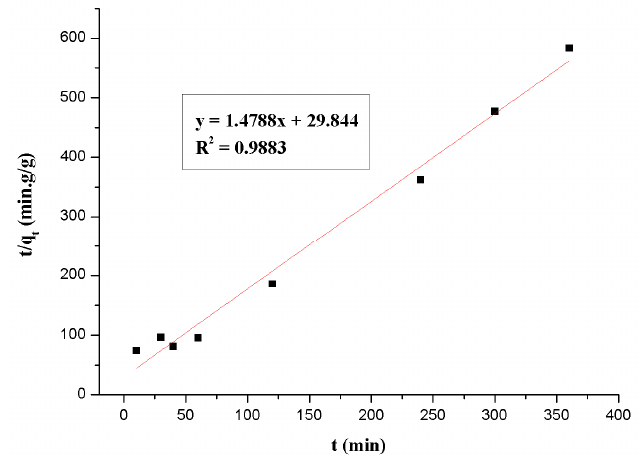
Figure 5. Test of pseudo-second-order adsorption kinetics plot for Th(IV). ([Th(VI)] 0 = 6.5334 × 10 − 4 M, pH = 2.95 ± 0.05, T = 298.15 ± 1.00 K, I = 0.50 M NaNO 3